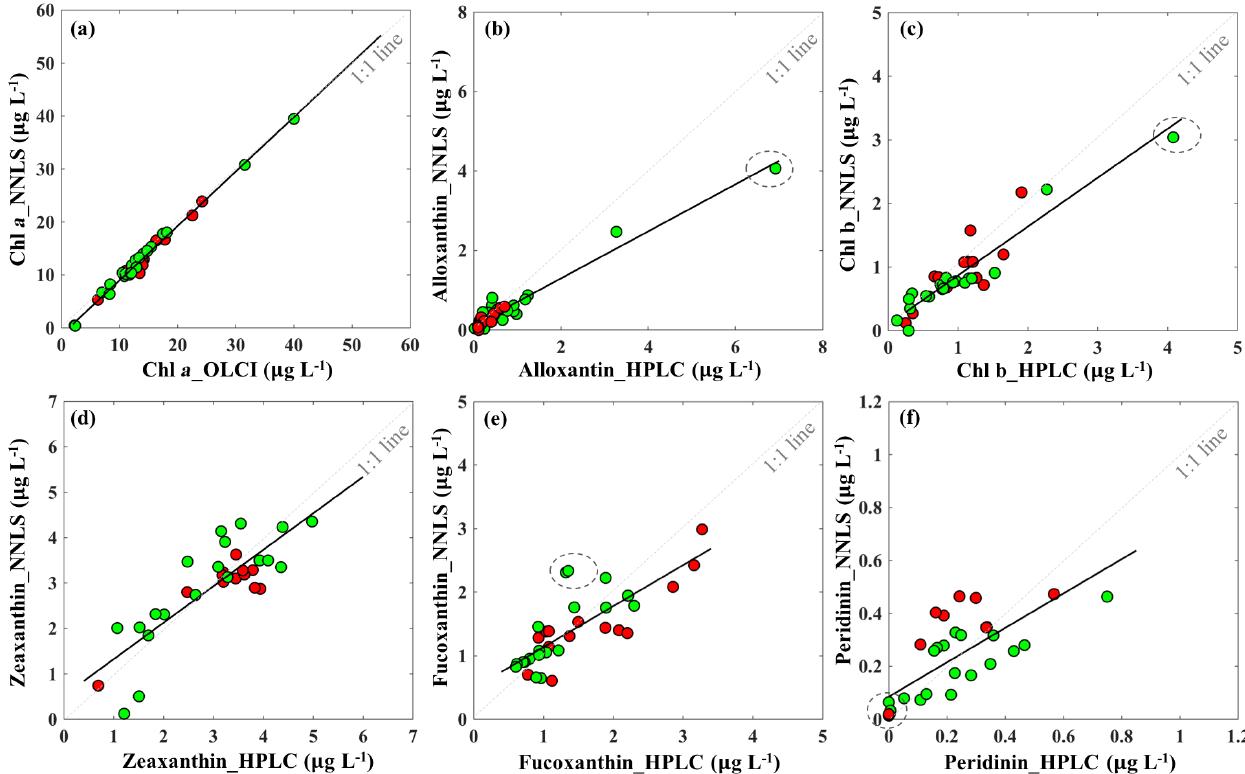
Figure 13. Sentinel-3A OLCI-derived pigment concentrations against HPLC-measured pigment concentrations in Galveston Bay: (a) Chl a , (b) alloxanthin, (c) Chl b , (d) zeaxanthin, (e) fucoxanthin and (f) peridinin. Red and green symbols indicate data sets obtained on 29 Septem- ber and 29–30 October 2017, respectively. The dashed circle includes the station located in algal bloom